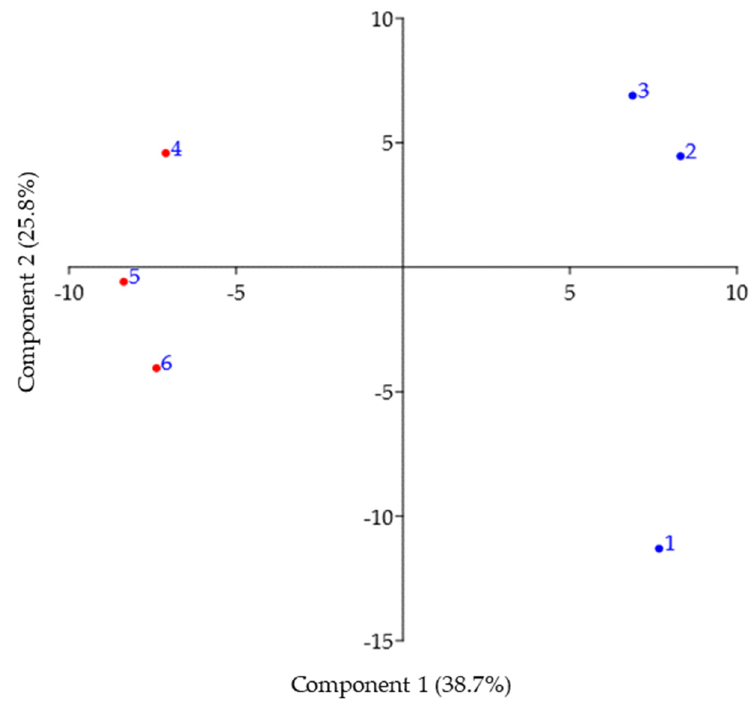
Figure 2. Principal component analysis (PCA) of metabolomic samples from winter (1, 2, 3) and summer (4, 5, 6) bodies of Cinara tujafilina .